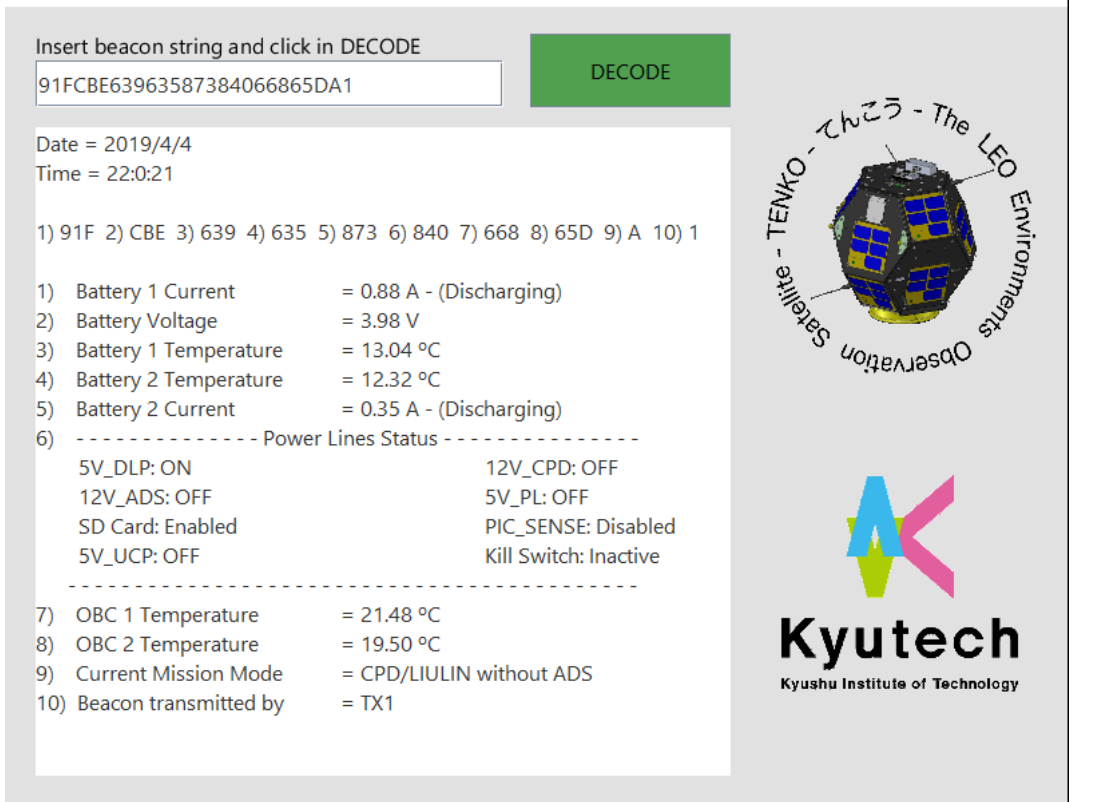
Figure 17. Last decoded beacon received from Ten-Koh over Greece on 19 March 2019. Note that “Date” and “Time” correspond to the time when the beacon was decoded, not when it was